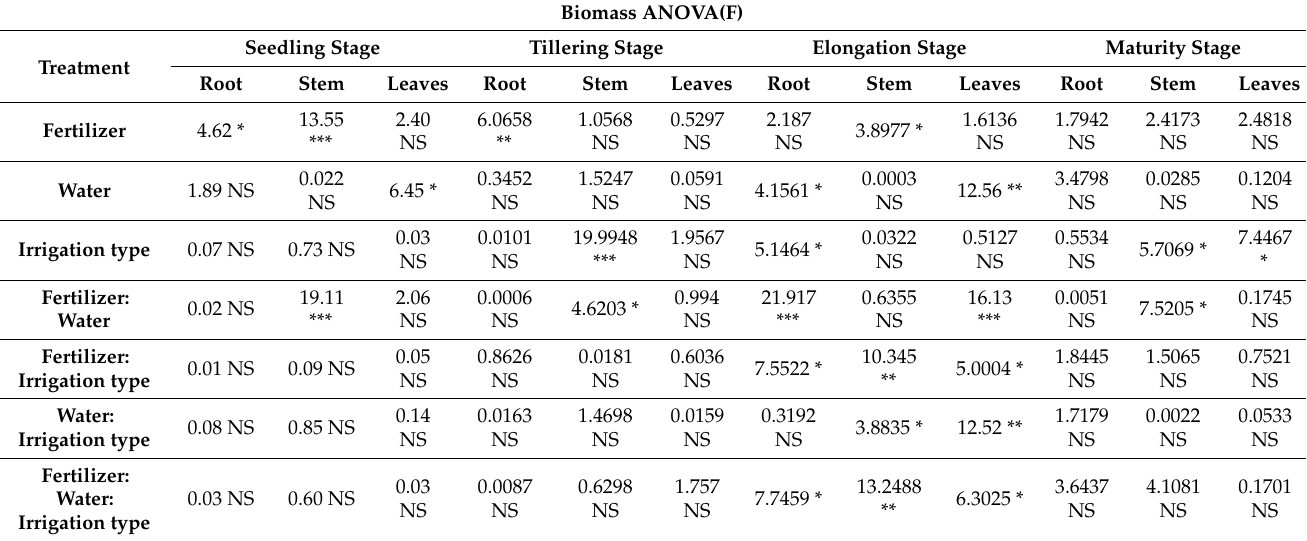
Table 2. Results of multivariate analysis of variance (ANOVA) of biomass at different growth stages of sugarcane under different water-fertilizer-irrigation method treatments.